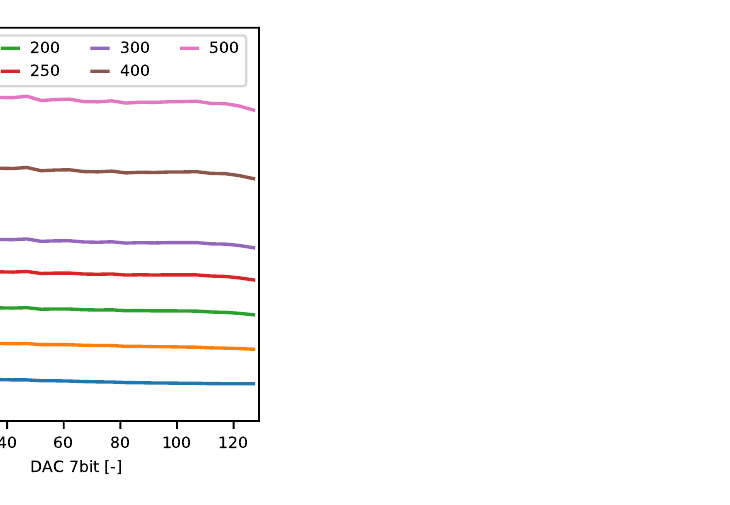
Figure 21. Measured gain of the test channel as a function of DAC 7bit value controlling the amplitude of the looped stimulation output current for different gain settings.